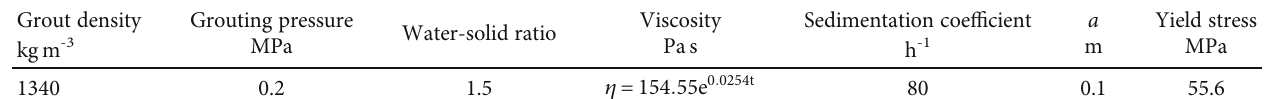
Table 3: Main parameters for simulation.